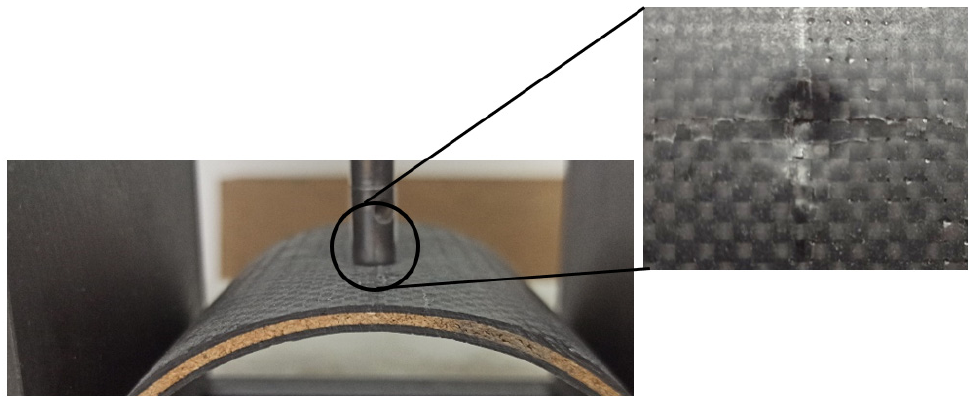
Figure 6. Failure mechanisms for composite sandwich cylindrical shells.